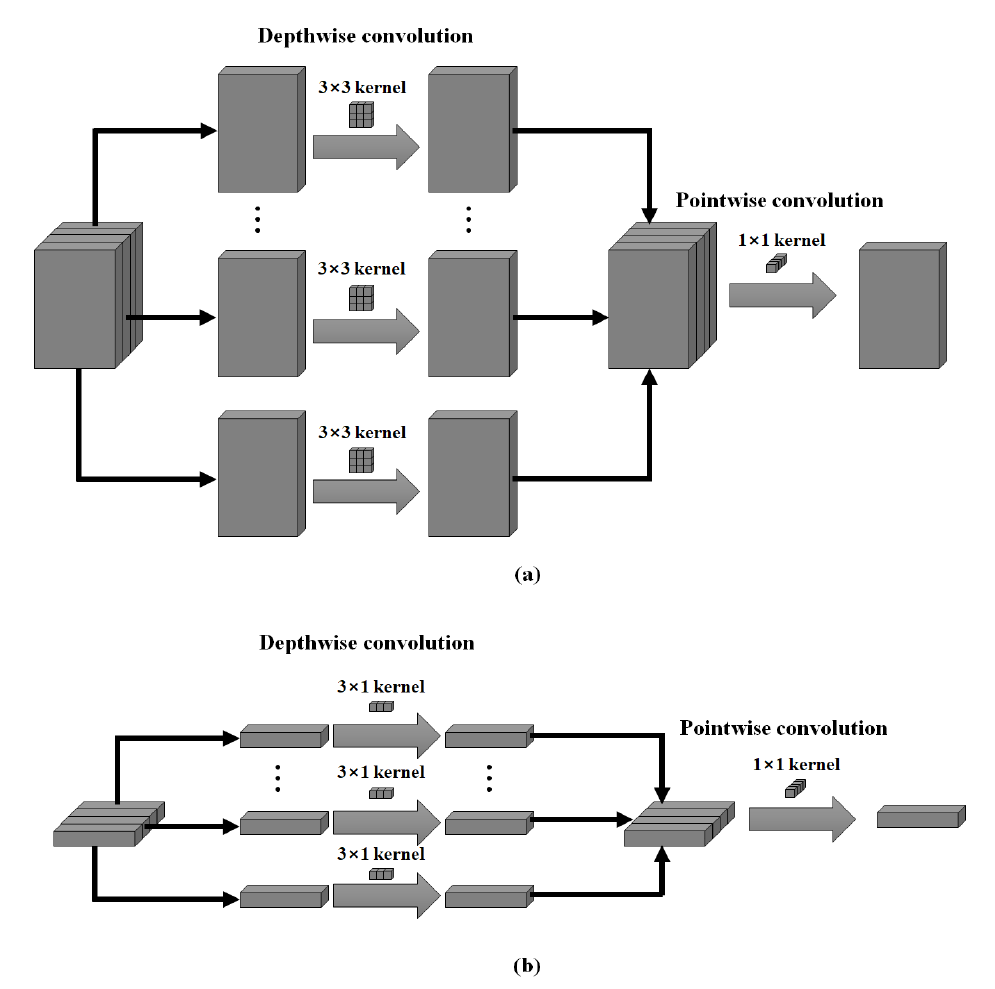
Figure 5. ( a ) Original architecture of MobileNet; ( b ) Modified MobileNet architecture for the PPG